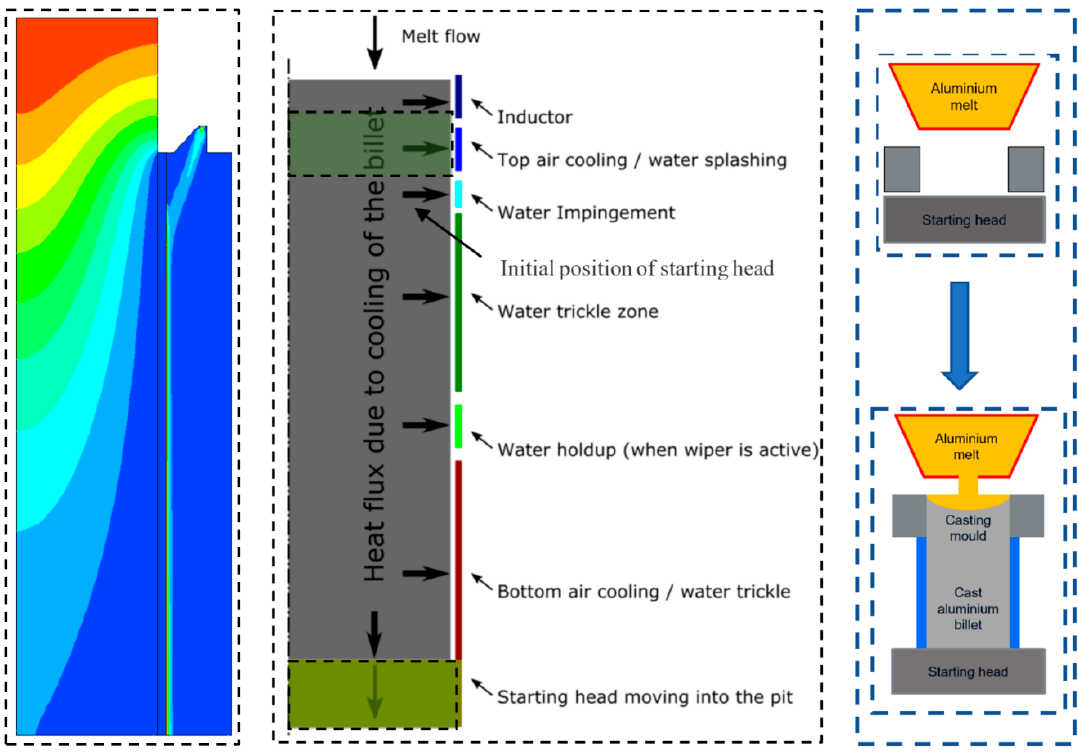
Figure 6. Thermal boundary setup for vertical casting process, including its air and water cooling strategies.